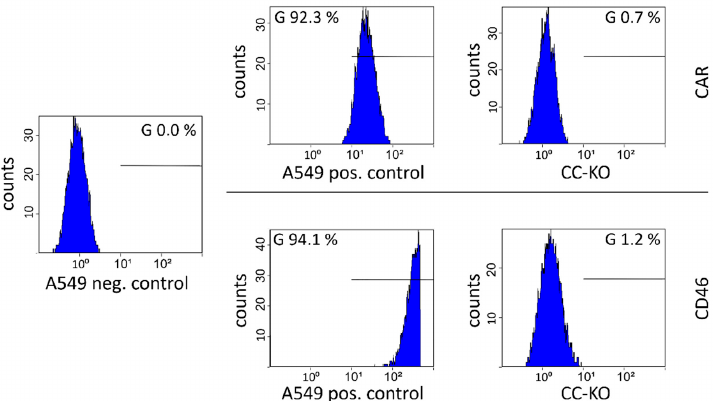
Figure 4. Establishment of a CD46/CAR double knockout cell line. The selected clone CC-KO exhibits a loss of CAR and CD46 protein expression in the FACS measurement. As the positive control, the parental A549 cell line incubated with the same primary antibodies was used. For the negative control, the parental A549 cells were incubated with the secondary antibody only. All measurements were carried out with the same monoclonal APC-linked secondary antibody.